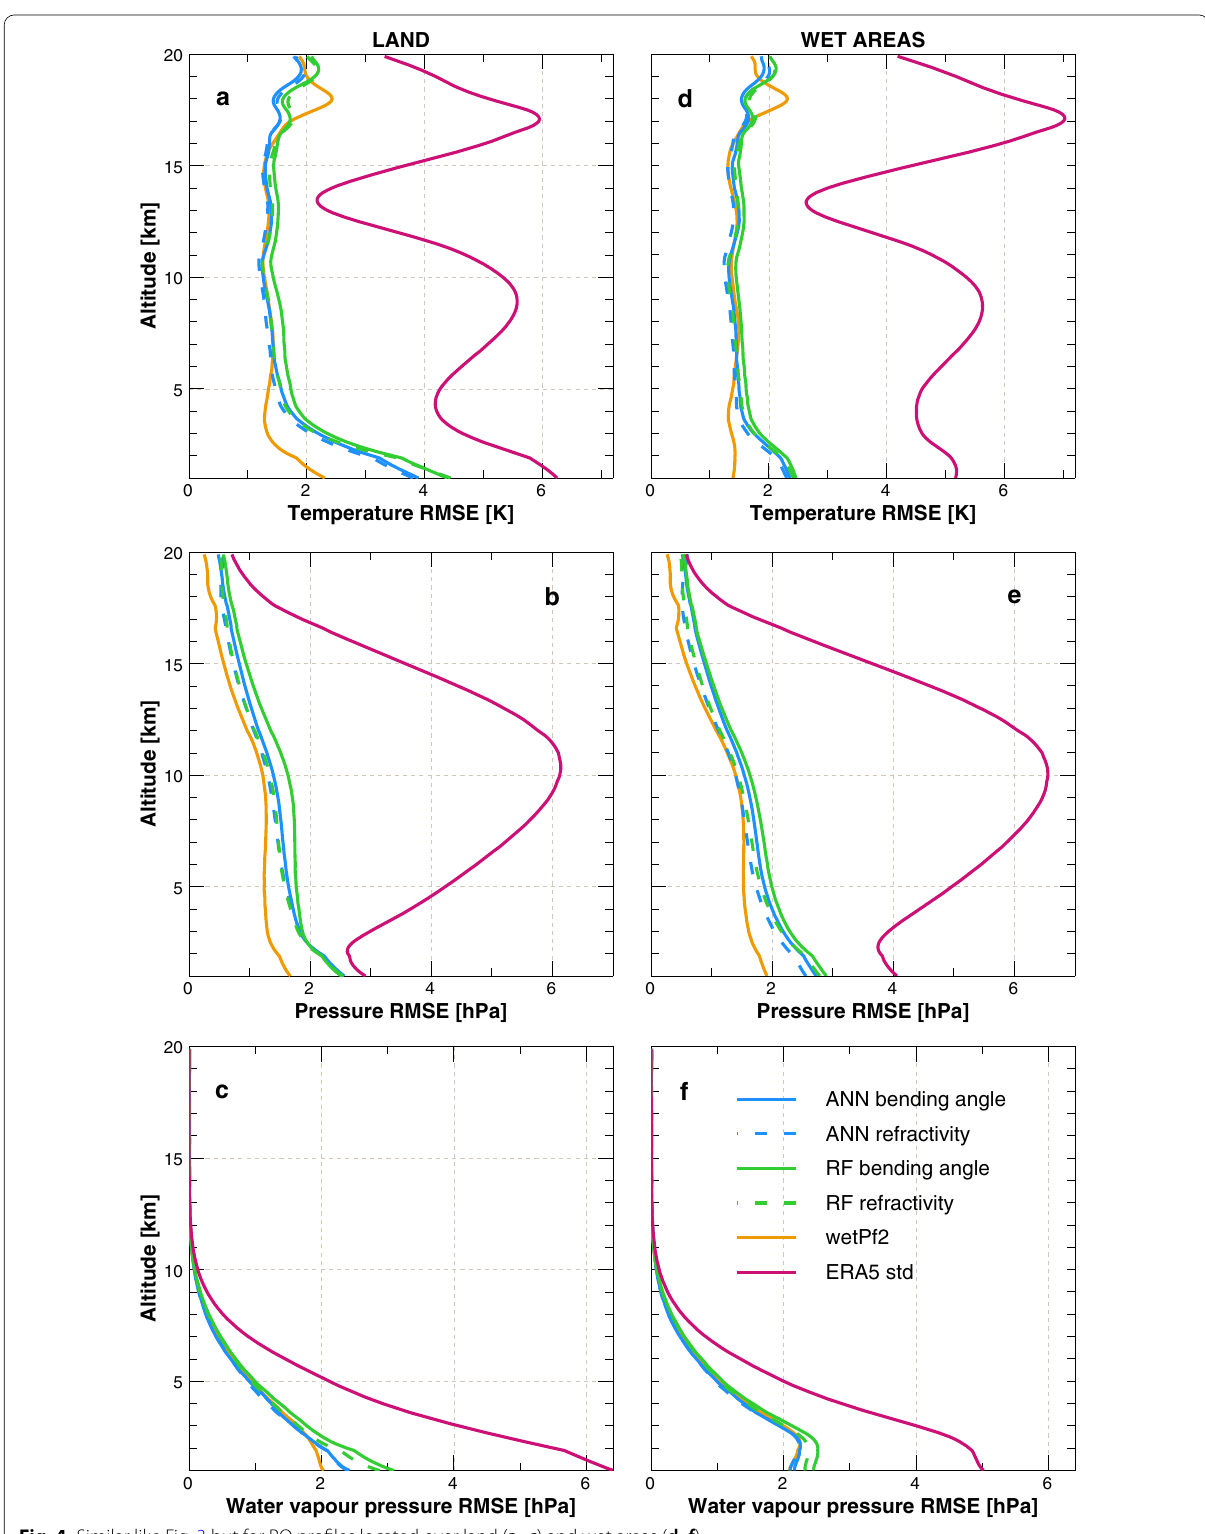
Fig. 4 Similar like Fig. 3 but for RO profiles located over land ( a–c ) and wet areas ( d – f